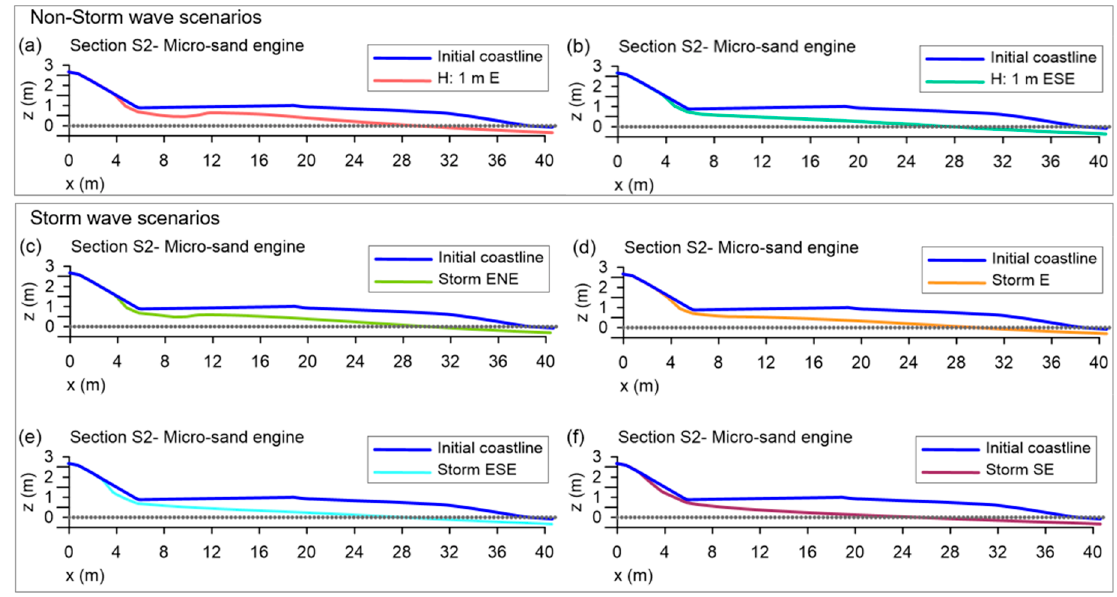
Figure 14. Variations in elevations of the transverse profiles, defined by the symmetry axis of the micro Sand Engine, (Section S2 in Figure 7d) (t: 30 h): ( a ) – ( b ) non ‐ storm wave conditions; ( c )–( f ) storm scenarios.